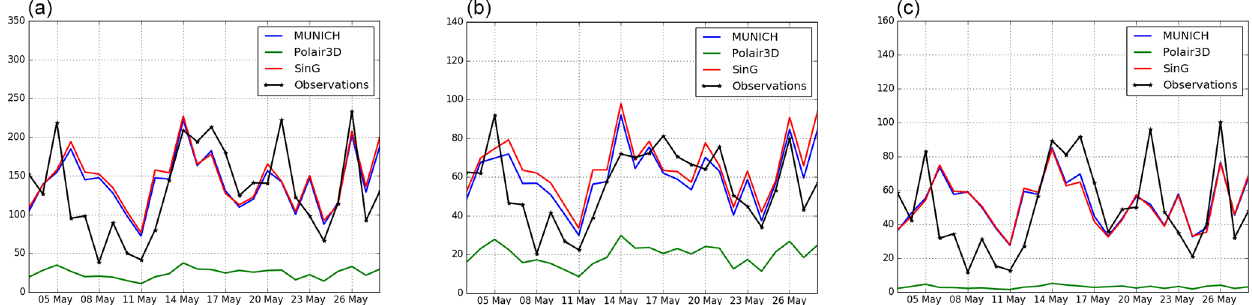
Figure 9. Daily average NO x (a) , NO 2 (b) and NO (c) concentrations (µgm − 3 ) observed and simulated at CELES station with MUNICH, SinG and Polair3D.